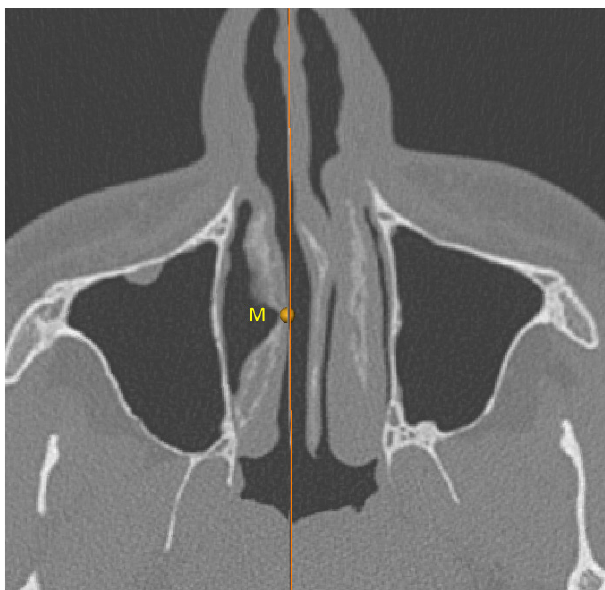
Figure 2. Linear regression of superior-inferior angle, depending on age. * Linear regression revealed statistical evidence after 60